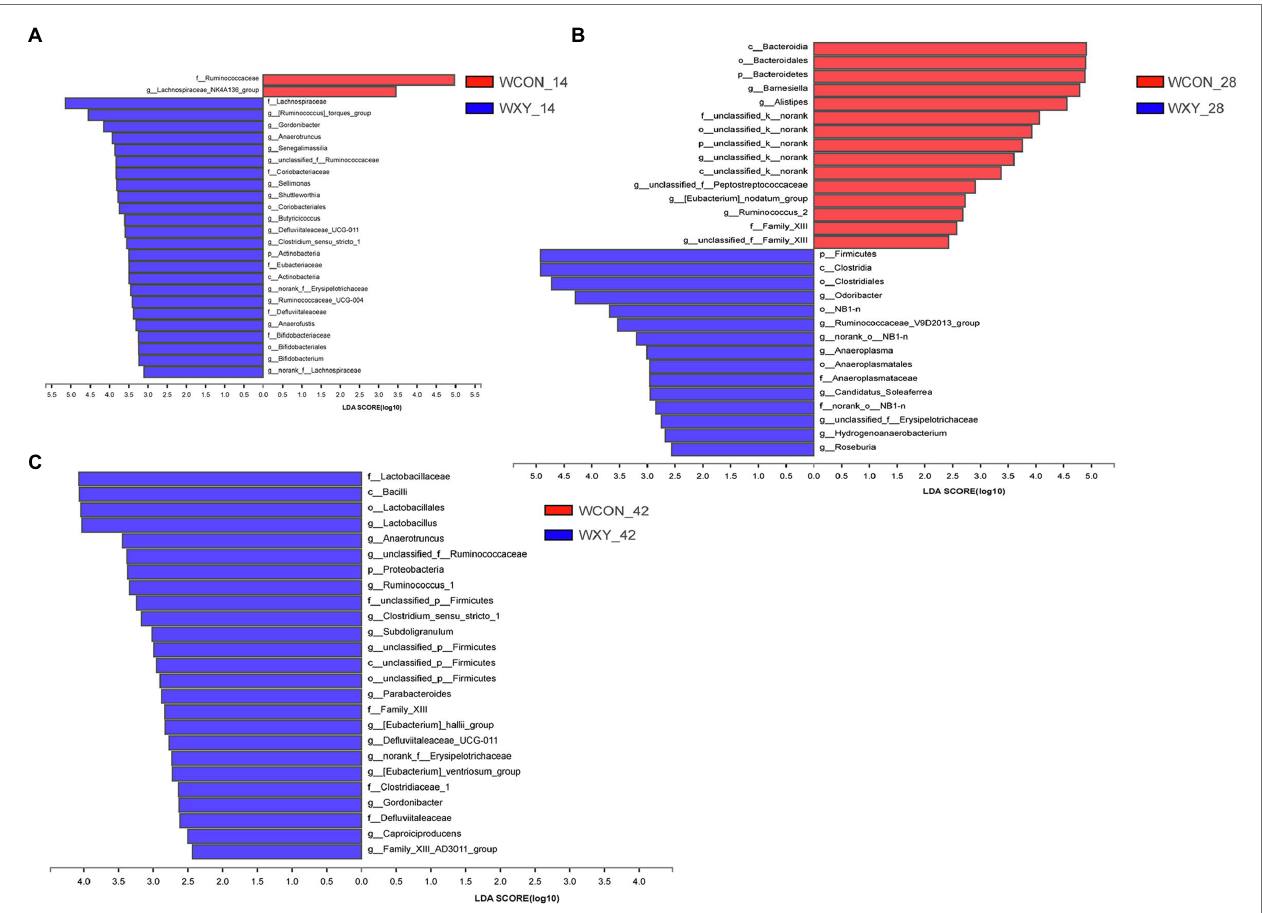
FIGURE 6 | The LEfSe analysis for cecal bacteria communities from phylum to genus level in WCON and WXY groups. Different bacterial communities from phylum to genus level between WCON (denoted by red bars) and WXY (denoted by blue bars) groups on d 14 (A) , d 28 (B) , and d 42 (C) . Wheat-soybean basal diet (WCON); wheat-soybean basal diet with 4,000 U/kg xylanase